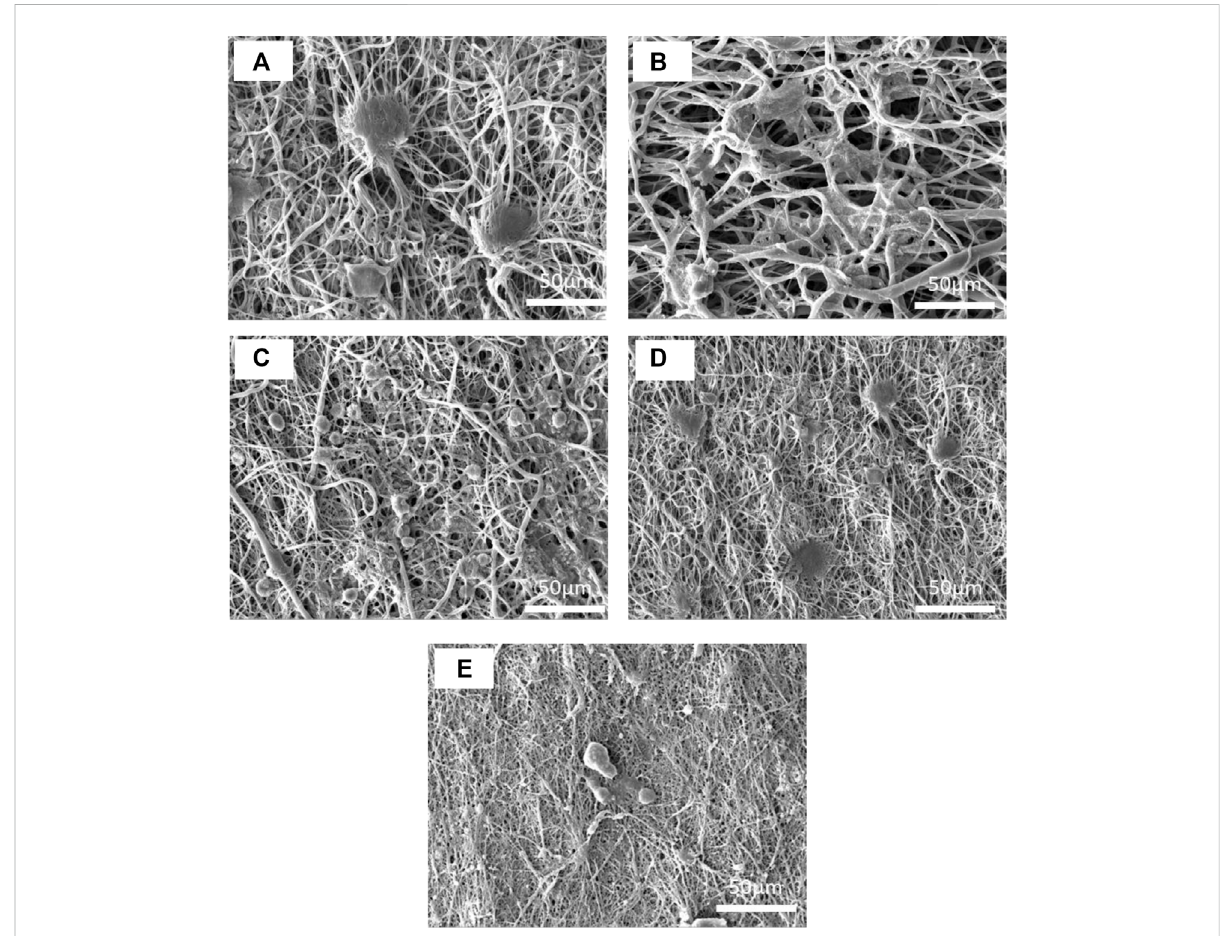
FIGURE 13 SEM images of L 929 fi broblast cells on the electrospun nano fi bers of (A) PCL15, (B) PCL15CS3, (C) PCL15CS3ZnO1, (D) PCL15CS3ZnO1Cur1, and (E) PCL15CS3ZnO1Cur3 after 7 days cell